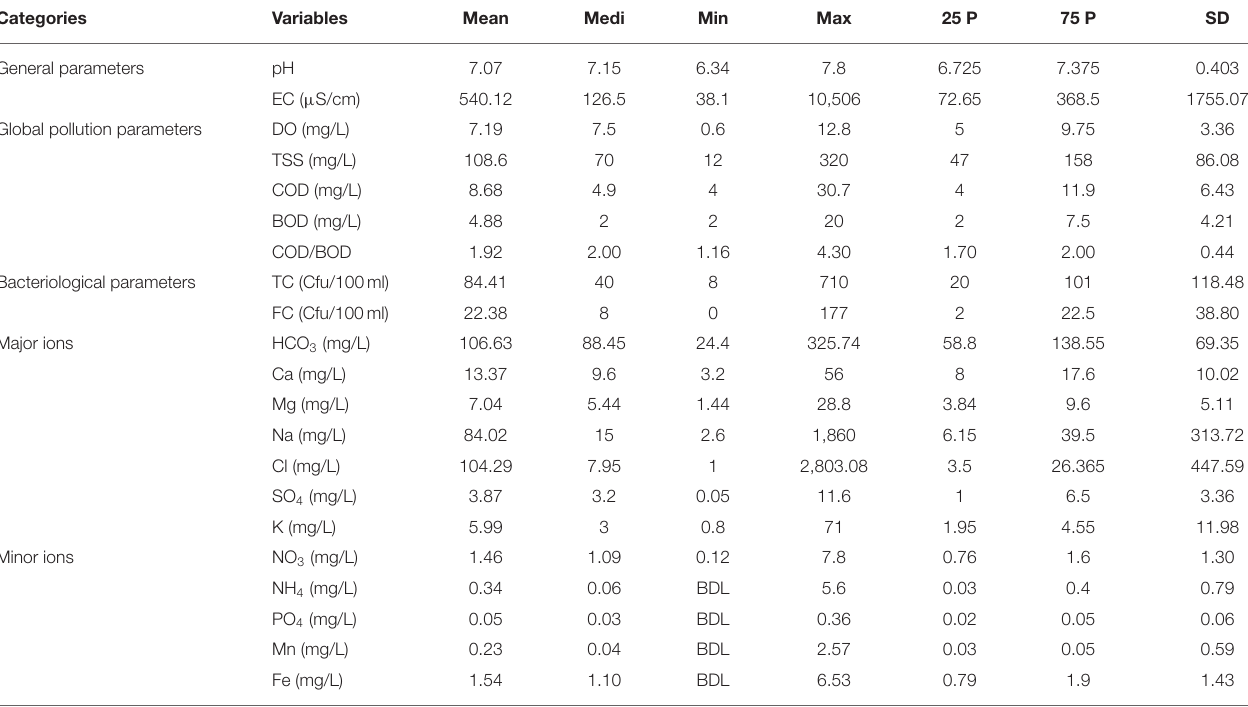
TABLE 2 | Descriptive statistics of water quality